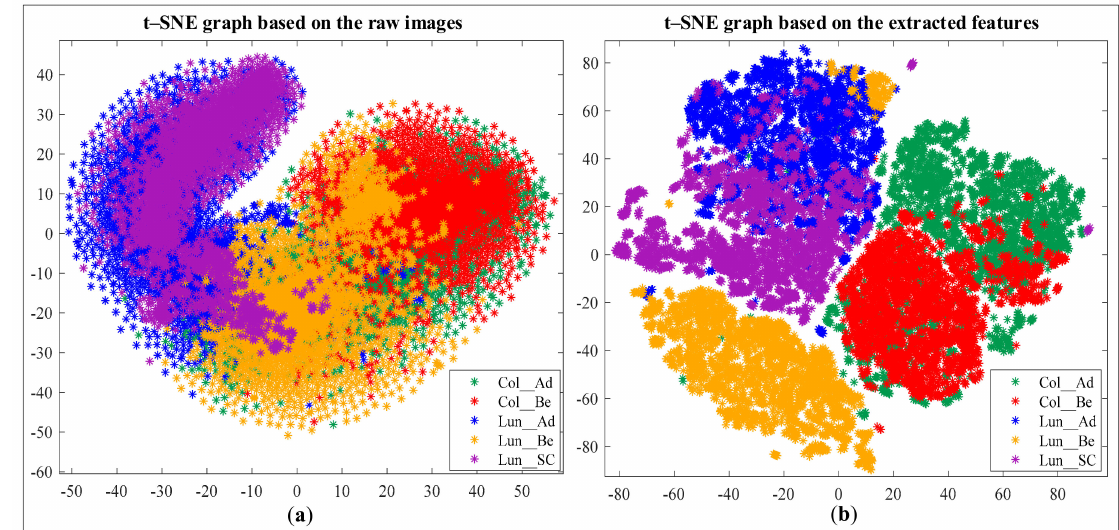
Figure 6. t-SNE graph of the dataset based on ( a ) the raw features and ( b ) the (combined) extracted